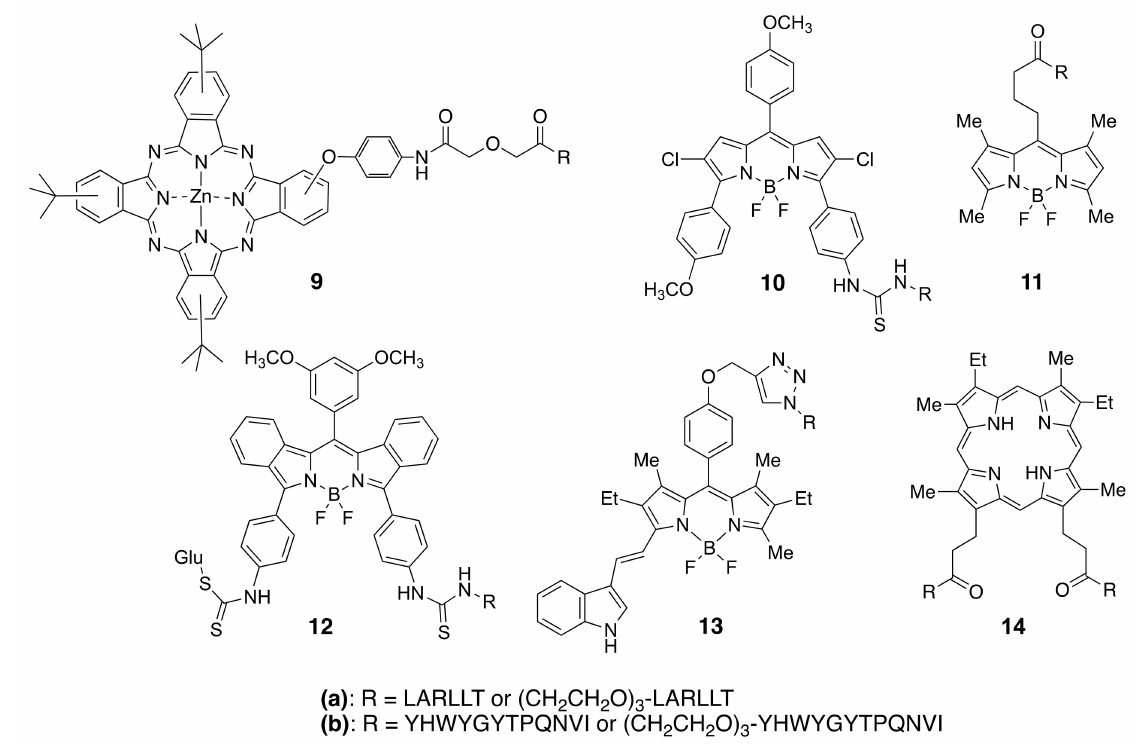
Figure 8. Structures of fluorophores conjugated to EGFR-L1 and EGFR-L2